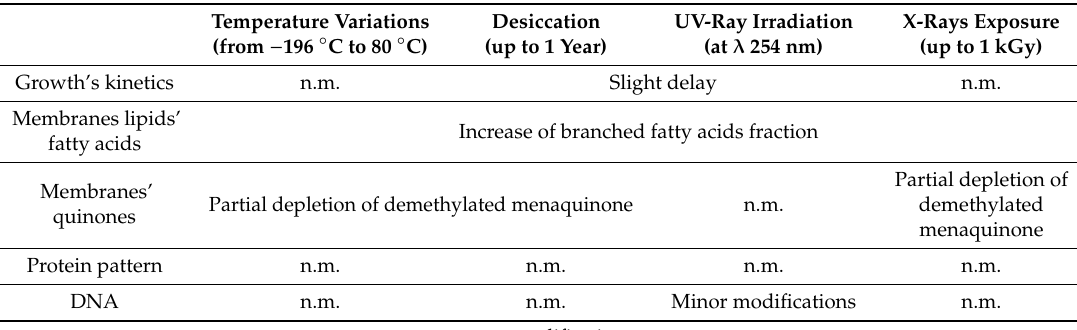
Table 5. Space simulation e ff ects on survival and cellular structures of P.